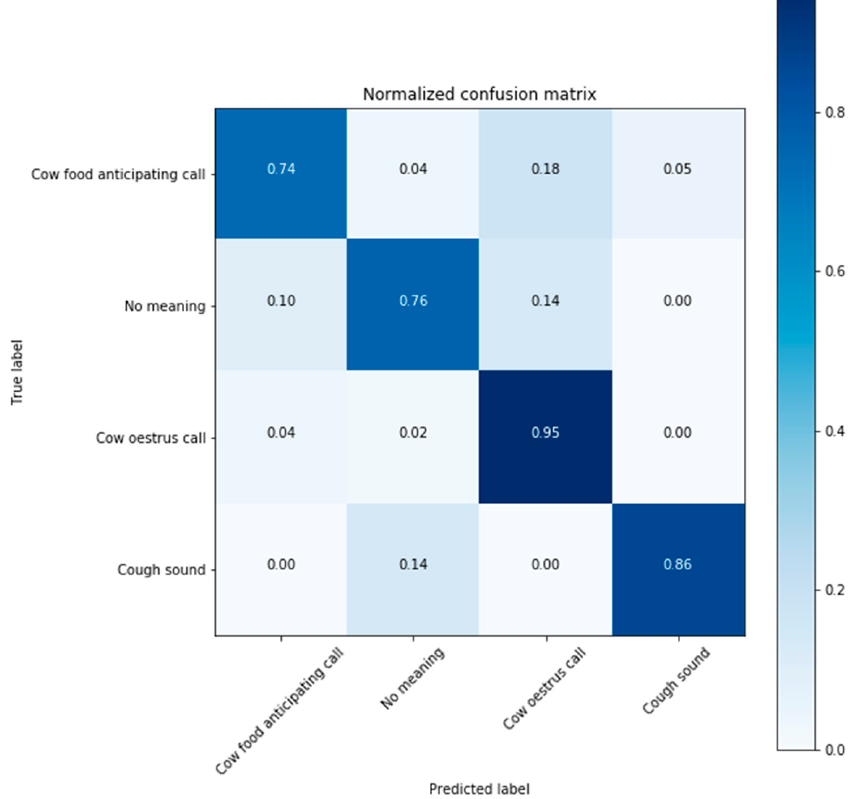
Figure 13. Confusion matrix of the CNN model classification accuracy for four behavioral cattle voices.